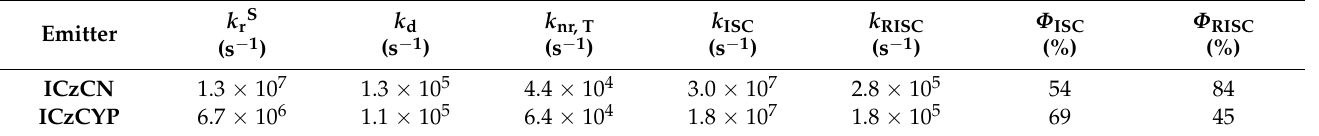
Table 2. Photophysical properties of 12 wt% ICzCN :PPF and ICzCYP :PPF doped